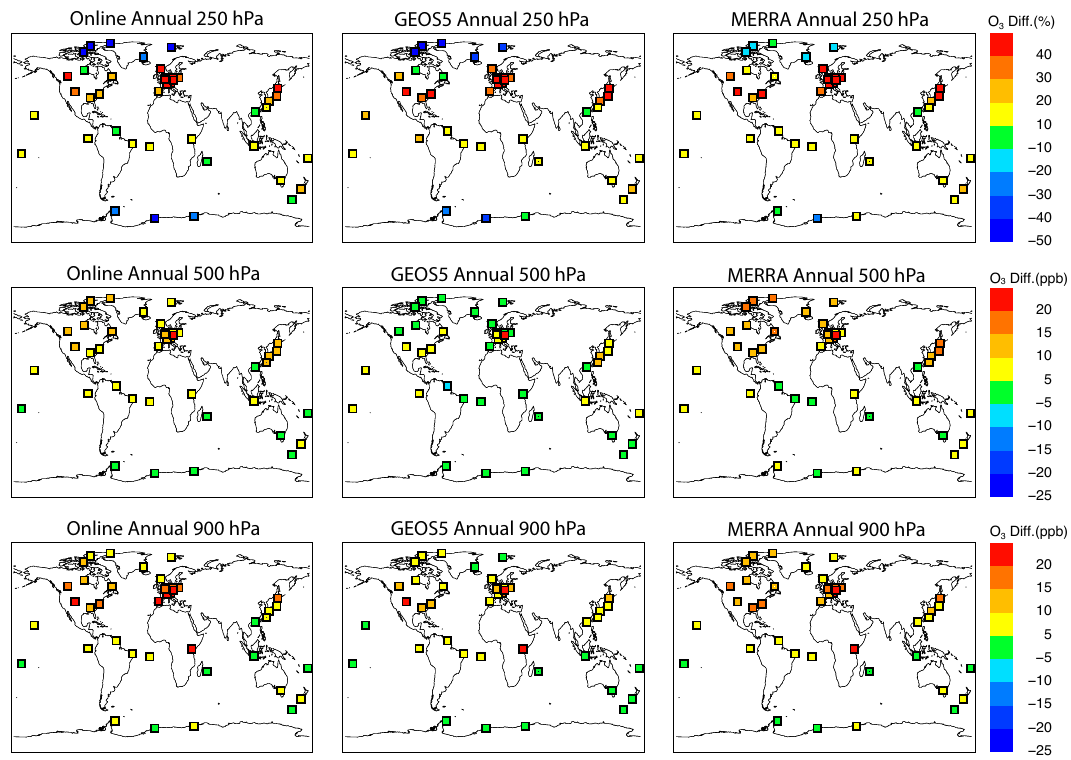
Fig. 5. Mean annual bias of modeled ozone against ozone sonde climatology (Tilmes et al., 2011) for 3 pressure levels; each square indicates the bias at the location of the ozone sonde. Averaging is done over the overlap period between the model simulations and the observations for each